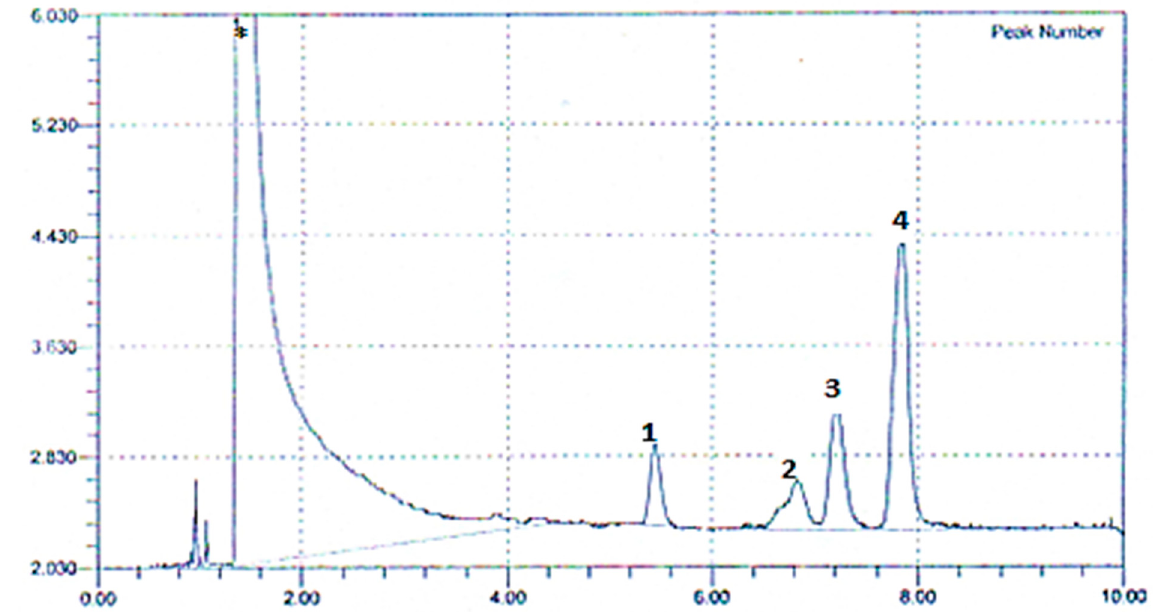
Figure 14. Amino acid at 4 mL/L GLC. (* is the solvent, 1 is the palmitic acid, 2 is oleic acid, 3 is a Linoleic acid and 4 is the α - α linolenic acid) of chia ( Salvia hispanica L.) fixed oil content as impacted by various bio-stimulating materials.